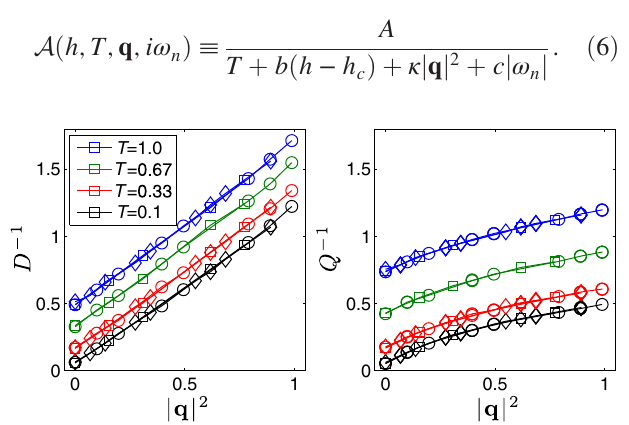
FIG. 11. Inverse nematic and quadrupolar correlators versus j q j 2 for all orientations of q at h ¼ h c and T from 0.1 to 1.0. Momenta from multiple system sizes (represented by squares for L ¼ 16 , circles for L ¼ 20 , and diamonds for L ¼ 24 ) fall on the same curve, indicating that the properties shown are in the thermodynamic limit. Error bars are smaller than the symbol size.